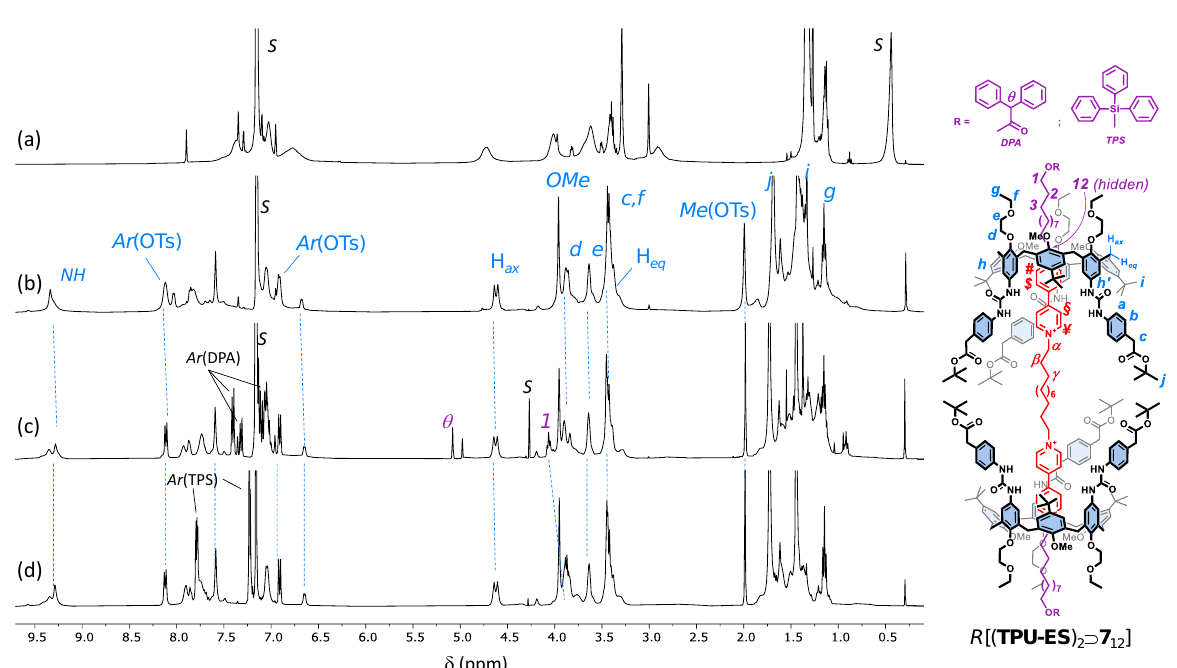
Figure 4. 1 H NMR spectra (400 MHz) of ( a ) TPU-ES , ( b ) [3]pseudorotaxane P [( TPU-ES ) 2 ⊃ 5 12 ], ( c ) R [( TPU-ES ) 2 ⊃ 7 12 ], and ( d ) [3]rotaxane R [( TPU-ES ) 2 ⊃ 8 12 ] in C 6 D 6 (see the sketch on the right for protons labels; the tosylates have been omitted for more